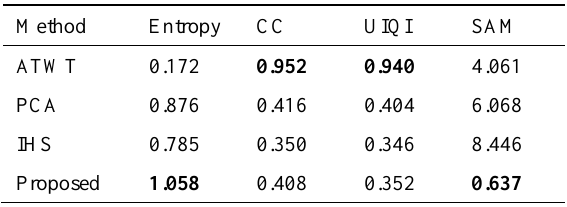
Table 2. Quality evaluation of fused images: Building (corresponding to Figure 4). The best performance of each metric is in bold.